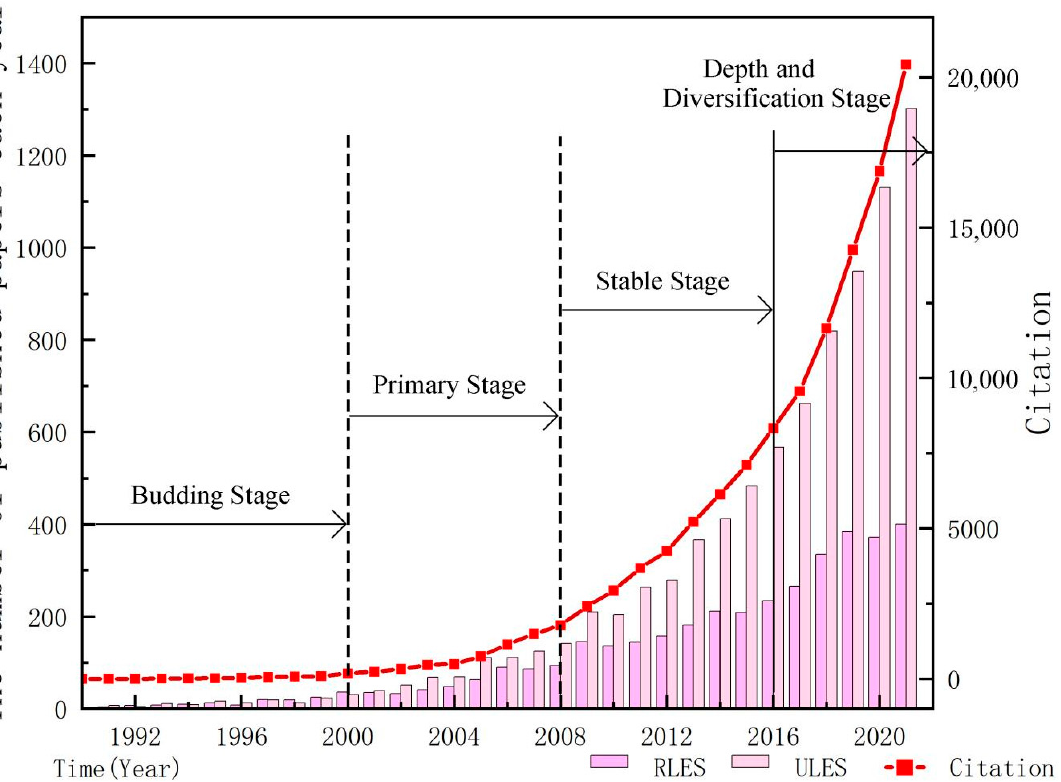
Figure 2. Numbers of annual publications and citations from 1990 to 2021. The colored bars indicate different research types.